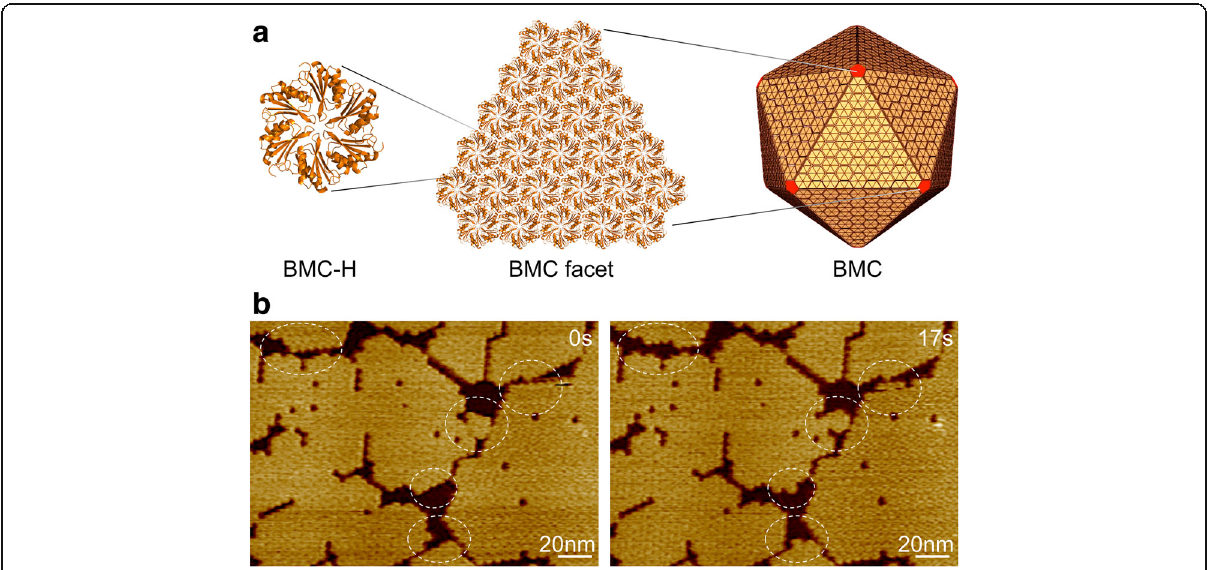
Fig. 1 Bacterial microcompartment, shell organization, and self-assembly. a Hundreds of copies of BMC shell protein homologs self-assemble to form an icosahedral protein organelle. BMC-H proteins, in yellow, form the facets and BMC-P proteins, in red, occupy the vertices. b AFM topographs of shell facets composed of Hoch_5815 BMC-H hexamers. Dynamic events (circles) were observed within seconds using